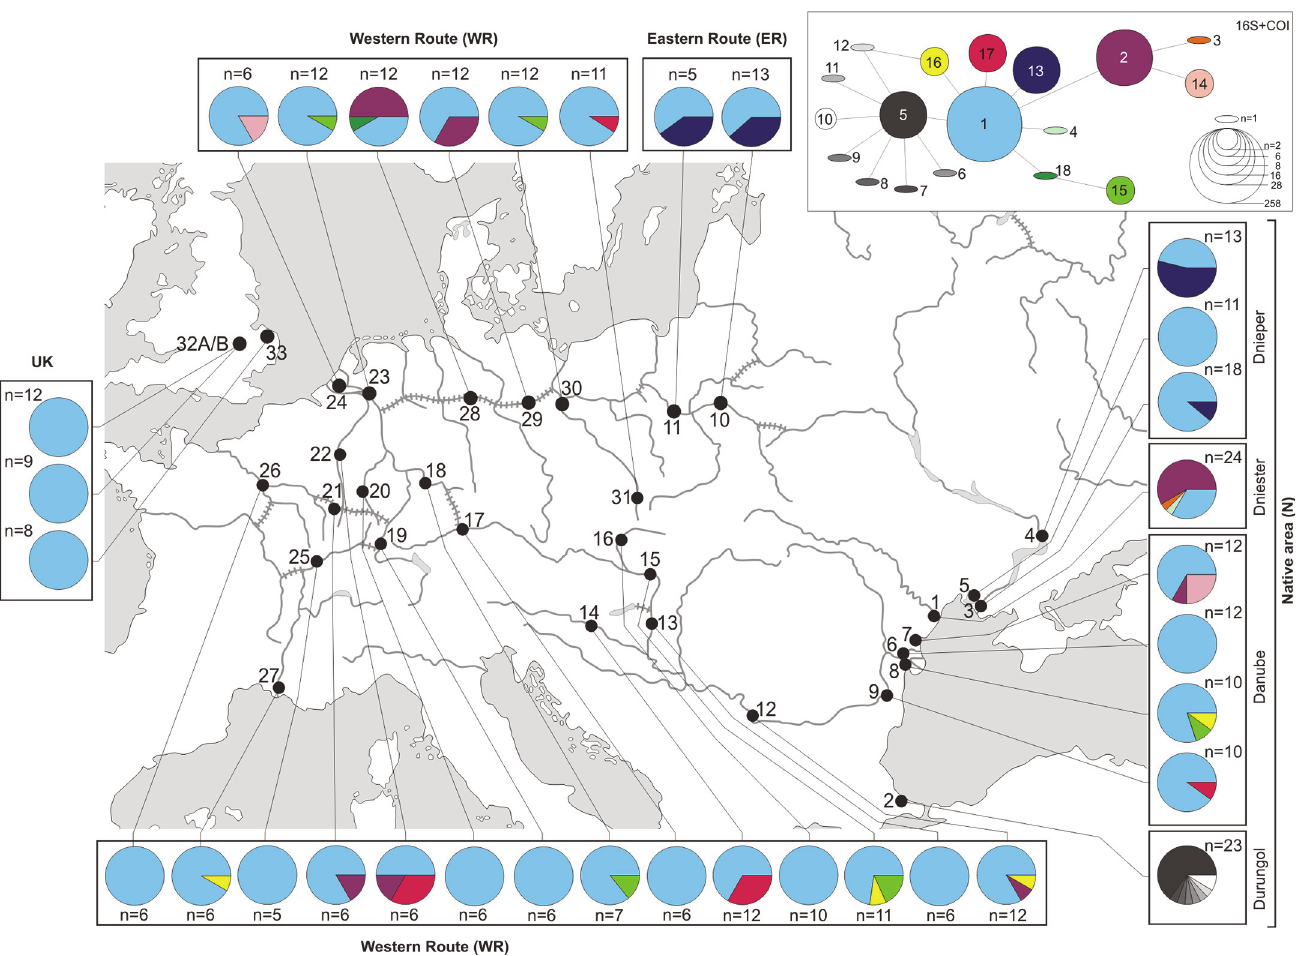
Fig 2. Geographical distribution of D. villosus haplotypes in the native and invaded area. Numbers near black circles represent sampling localities coded as in Table 1. In upper right corner is the minimum spanning network of mtDNA haplotypes identified in D. villosus .